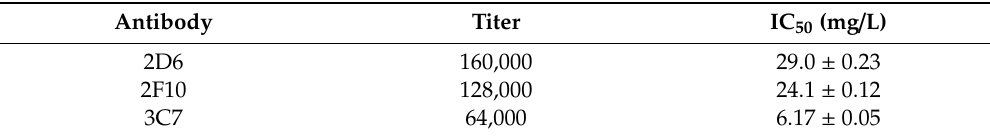
Table 1. Titre and IC 50 of the